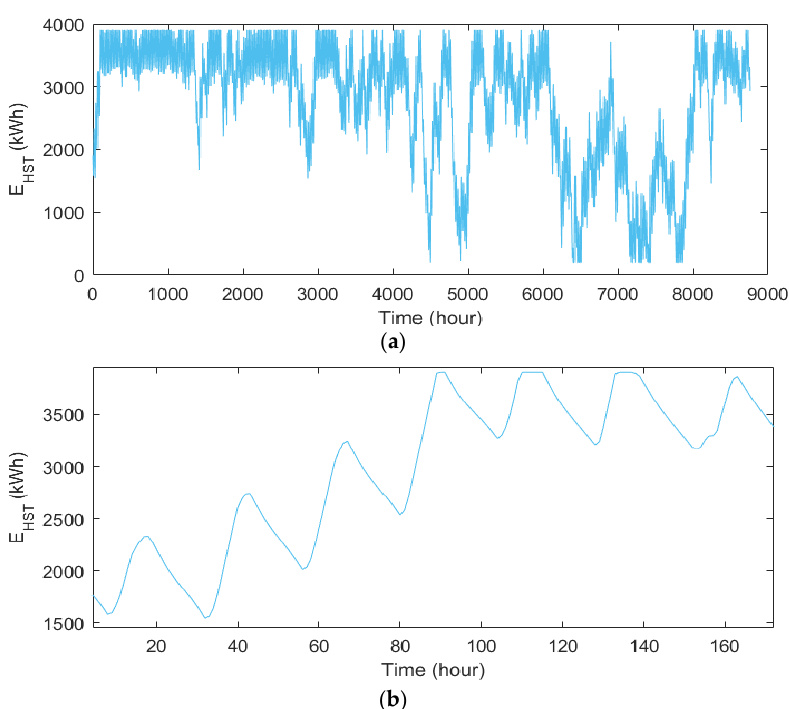
Figure 7. Generated power from PV resources considered in the sizing of the HPV/FC energy sys- tem via the IAEO, considering ENSP max = 1% during ( a ) a year and ( b ) a week.